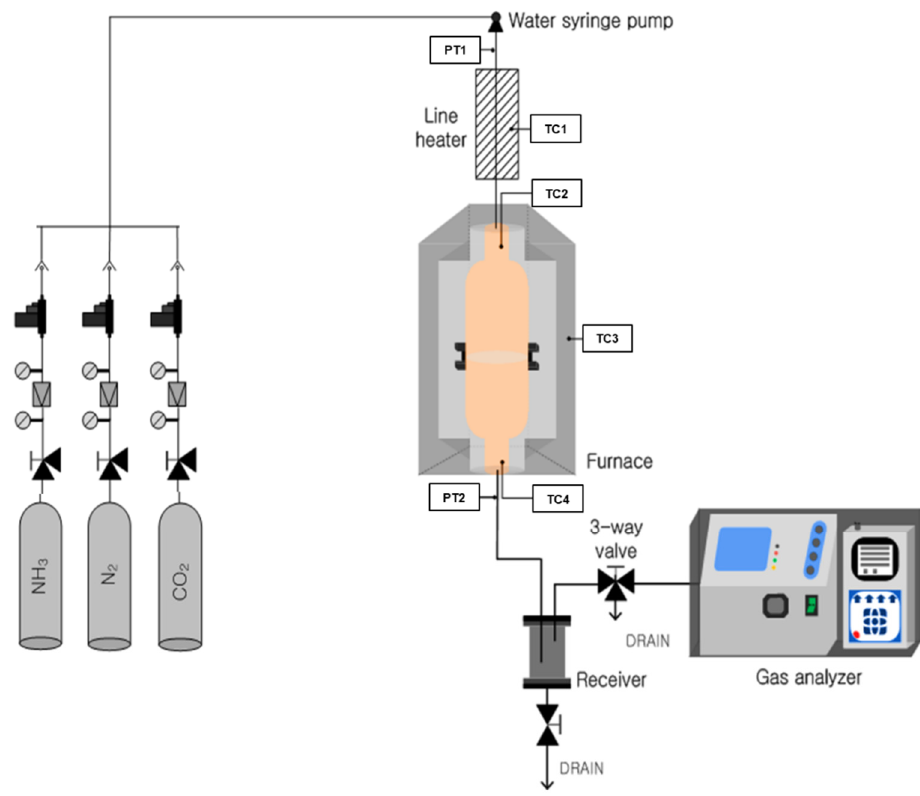
Figure 12. Schematic diagram of the experimental setup for the NH 3 -TPD test.